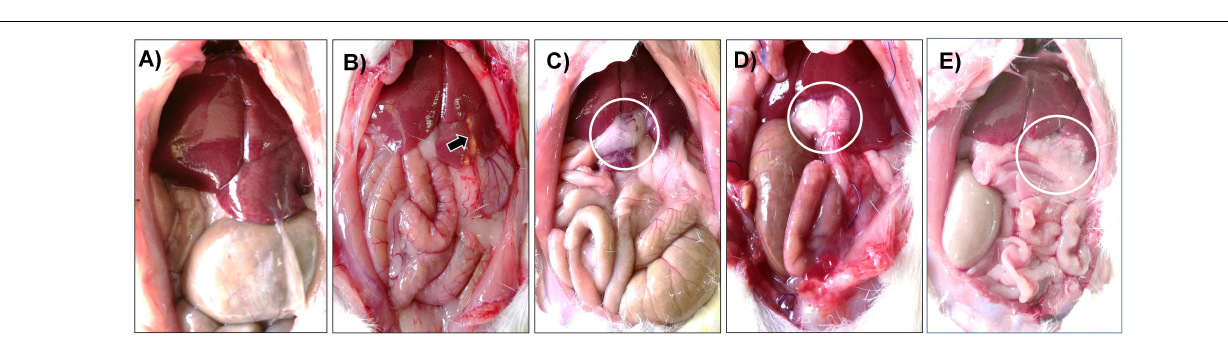
FIGURE 2 | Macroscopic evaluation of animals after surgical procedures. Representative laparoscopy examination of the sham (A) and PH (B) animals at day 21; analysis showed normal organs. The PH group showed a scar at the 40% hepatectomy site (arrow). The PH + CMS group at days 3 (C) , 14 (D) , and 21 (E) showed evident adipose tissue surrounding the xenoimplant (circles) but with no adjacent organ alteration or